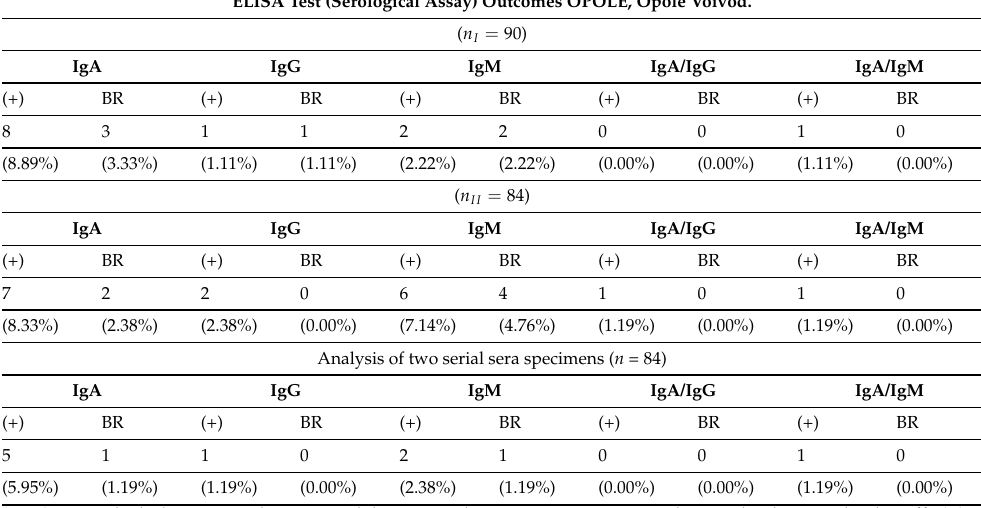
Table 2. Positive rates of the serological tests in HCWs* included in the study from the University Hospital in Opole. ELISA Test (Serological Assay) Outcomes OPOLE, Opole Voivod.